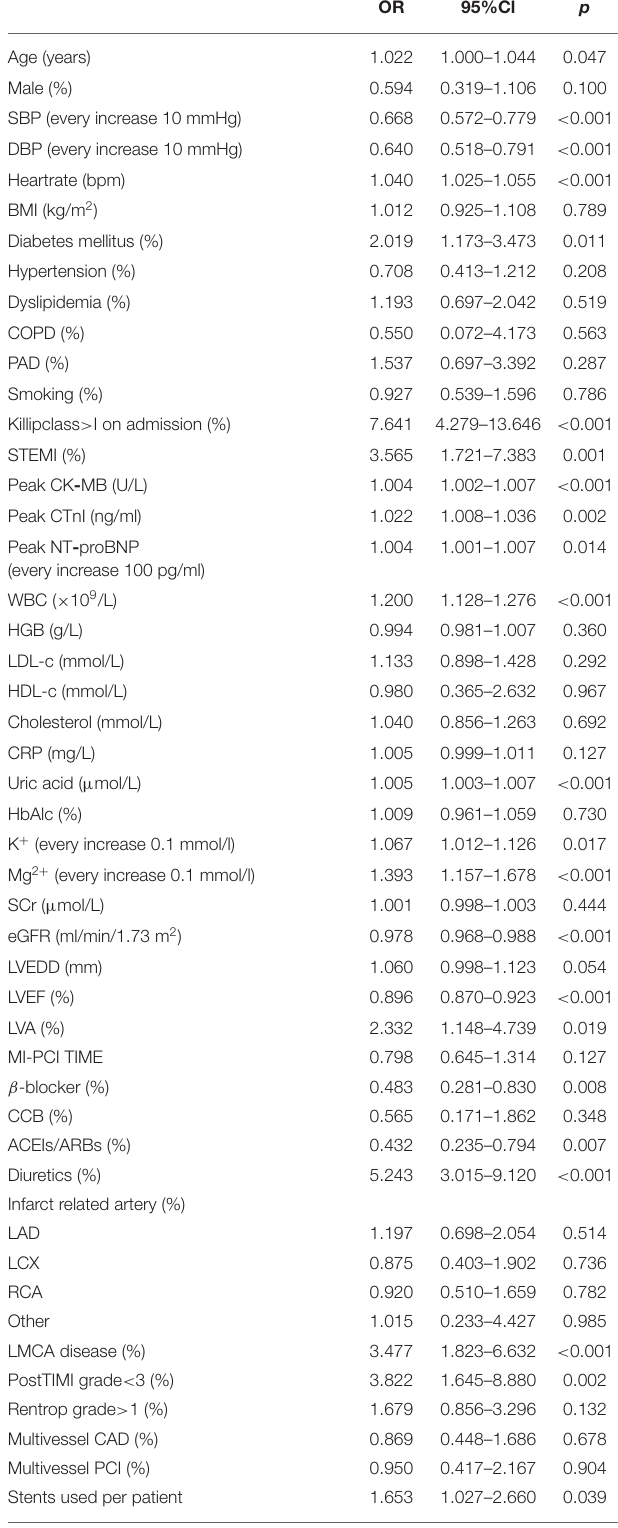
TABLE 2 | Univariable logistic regression analysis for relevant factors of VT/VF after acute myocardial infarction (AMI).